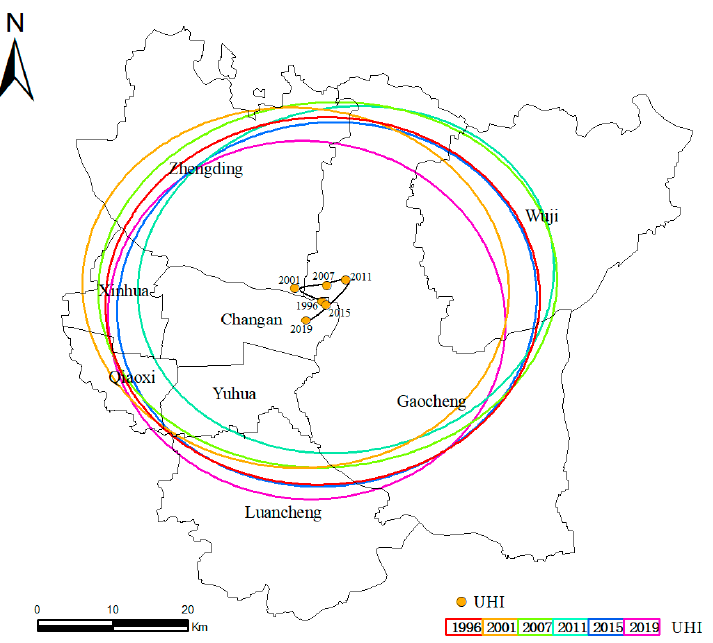
Figure 6. Evolution of center points and standard deviation ellipse (SDE) of the urban heat island (UHI) of the study area from 1996 to